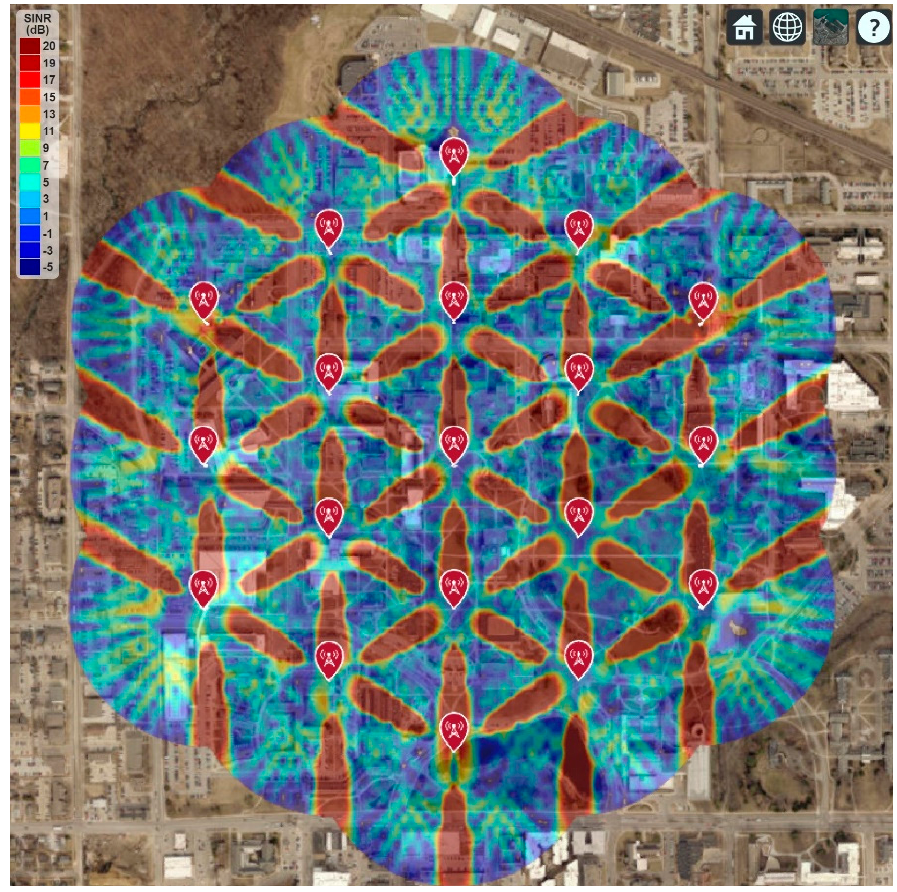
Figure 18. 5G Network Coverage and SINR Map for 16-by-16 Antenna Array. For optimal performance (e.g., 99.99% network availability, 99% network reliability, maximum data rate, etc.), the 5G network will require high SINR, which can be achieved using the larger size phased array antenna for each cell site. The phased array antenna also allows changing the phase of the individual elements of the array. It can be used to steer the transmitted signal in any particular direction to improve the 5G network coverage. However, the 16-by-16 array provides a highly directional and narrow radiation beam, shown in Section 2. It causes maximum SINR toward the direction of each sector but minimum in all other directions, as shown in Figure 18. Thus, the average SINR will significantly vary throughout the deployment area, impacting the overall system per- formance. Therefore, Section 4 proposes an updated cell site architecture to improve RF coverage, including higher-order sectorization and adjusting antenna parameters (e.g., antenna downtilt, antenna height,